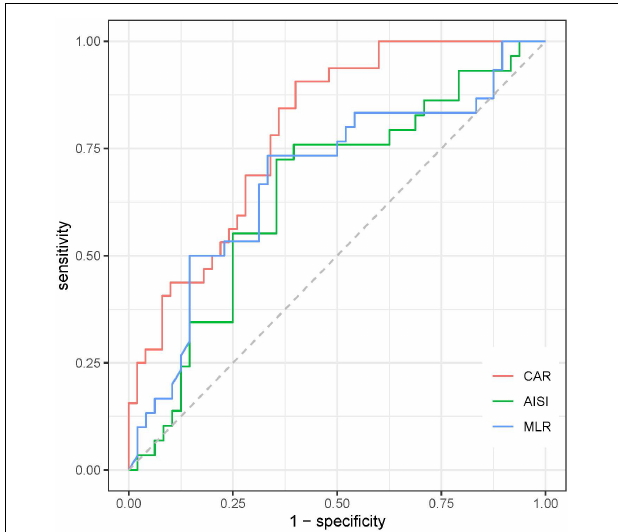
FIGURE 5 | The predictive value of MLR, AISI, and CAR in the poor prognosis of SFTS patients.